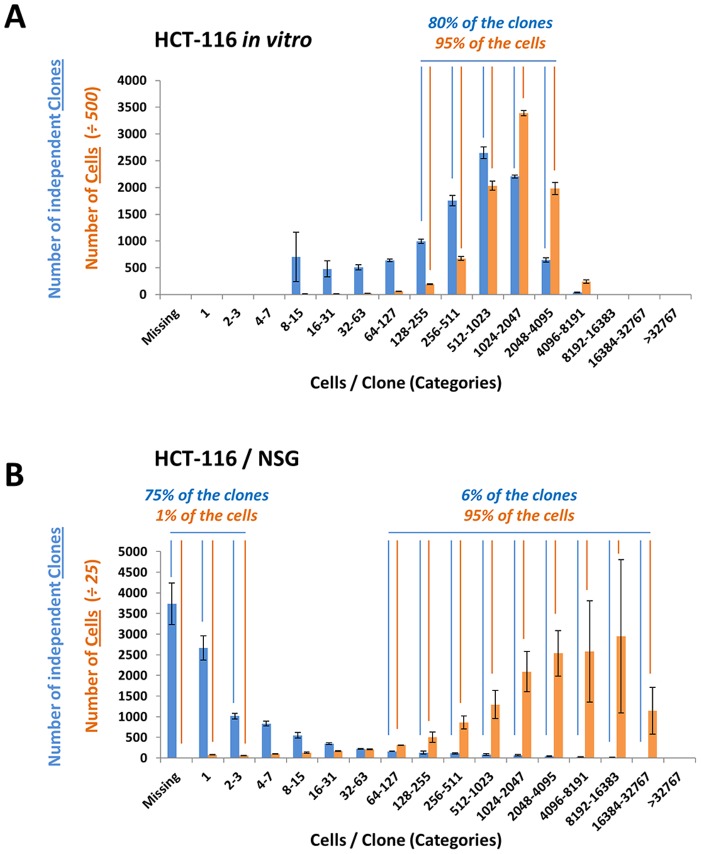
Evidence for clonal dominance: comparison of the distributions of HCT-116 barcoded clones and cells by clone size category in vitro and in vivo
.
For each graph, the number of independent clones (blue bars) or the total aggregate number of cells (orange bars) is plotted for each clone size category across the X axis. (A) Distribution of HCT-116 barcodes in vitro: 80% of the barcodes (clones) were identified in categories “128–255” to “2048–4095”, indicating that 80% of the cells divided between 7 and 12 times; 95% of the cells were identified in categories “128–255” to “2048–4095”, indicating that 95% of the cells belong to clones derived from 80% of the originally transduced cells, which divided between 7 and 12 times. Scale for number of cells was adjusted 500 fold to allow side by side comparisons of clone numbers and cell numbers. (B) Distribution of HCT-116 barcodes in
vivo: 75% of the barcodes are found in categories “missing” to “2–3”, indicating that they either didn’t survive at all, didn’t divide, or divided no more than once and represented only 1% of the retrieved tagged cells. However, only 6% of the bar-codes were located in categories “64–127” to “16384–32767”, indicating that they divided between 6 and 14 times; 95% of the cells accrued in categories “64–127” to “16384–32767”, indicating that 95% of the tagged cells are derived from 6% of the initially barcoded clones that divided the most. Scale for number of cells was adjusted 25 fold to allow side by side comparisons of clone numbers and cell numbers.